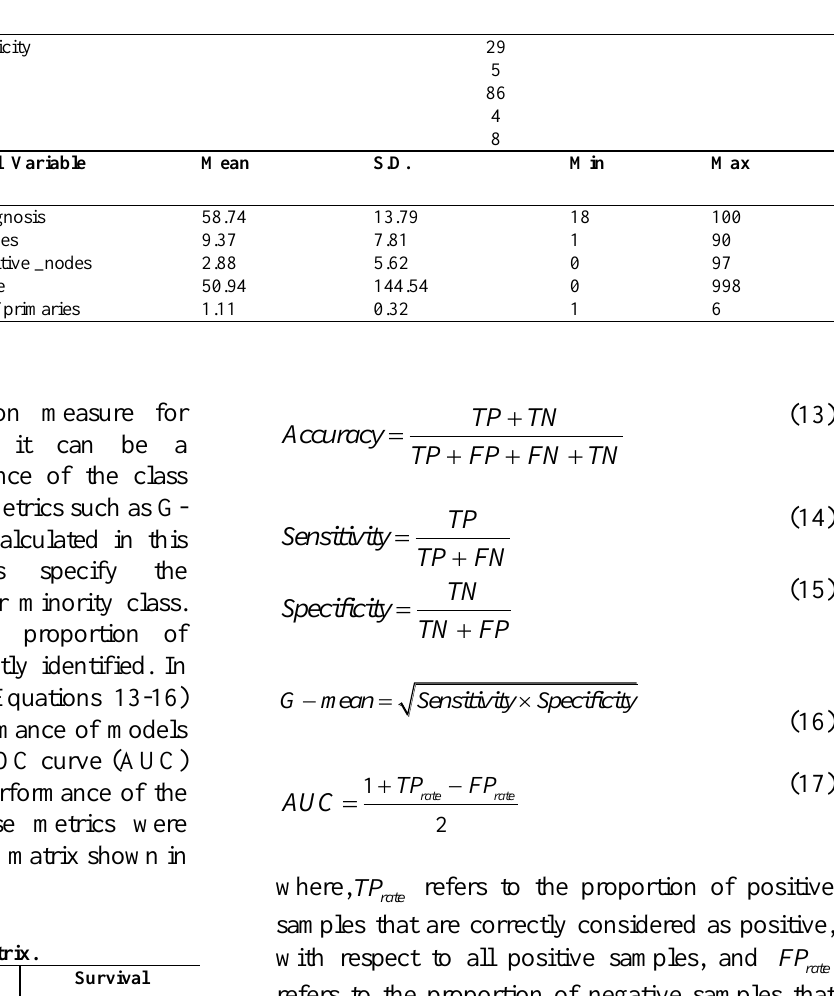
Survival Non-Survival Predicted